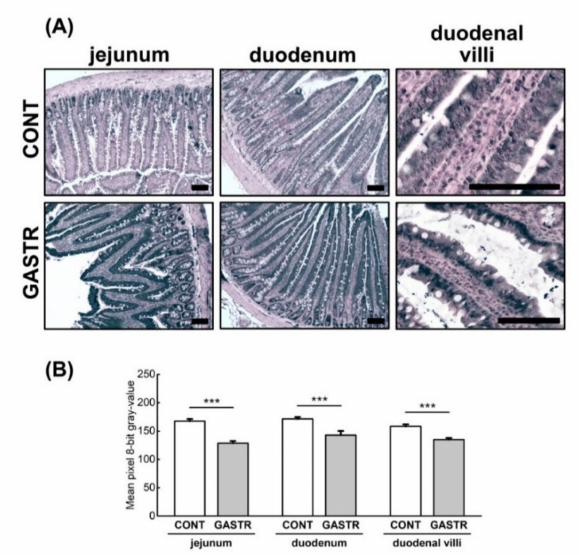
Figure 6. ( A ) Representative photomicrographs of the immunohistochemical reactions for zonula occludens 1 (ZO-1). Sections were developed in 3,3 (cid:48) -diaminobenzidine tetrahydrochloride with metal enhancer; counterstaining was performed with Nuclear Fast Red. All the scale bars represent 100 µ m. ( B ) The intensity of expression of ZO-1, measured by comparison of the pixel brightness values in the microscopic images converted to 8-bit grayscale. The higher the pixel value, the lower the intensity of immunoreactions. Graph shows mean ± standard error. Significance was established using a two-tailed Student’s t -test (normally distributed data), Welch’s test (normally distributed data with unequal variances) or the Mann–Whitney test (for pairwise comparisons with at least one non-normally distributed dataset); *** p <